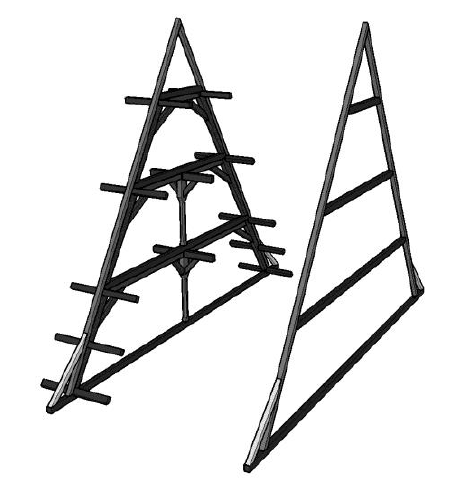
Figure 7a: Establishment of a truss